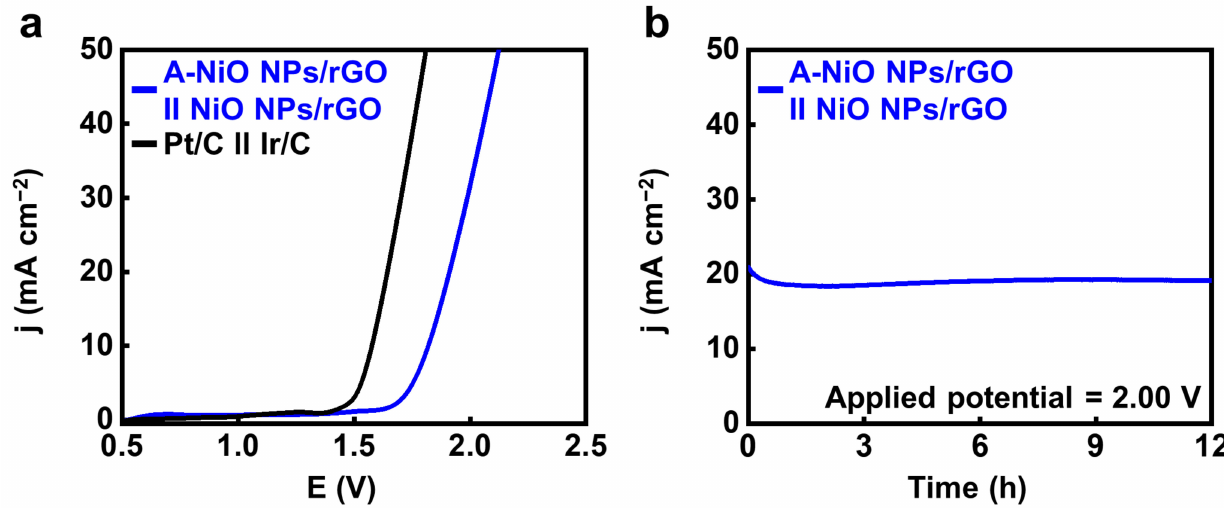
Figure 6. Overall water splitting test. ( a ) LSV curves of A-NiO NPs/rGO (cid:107) NiO NPs/rGO and Pt/C (cid:107) Ir/C in 1 M KOH at 5 mV s − 1 in a two-electrode system. ( b ) CA data for long-term durability at an applied potential of 2.00 V for 12